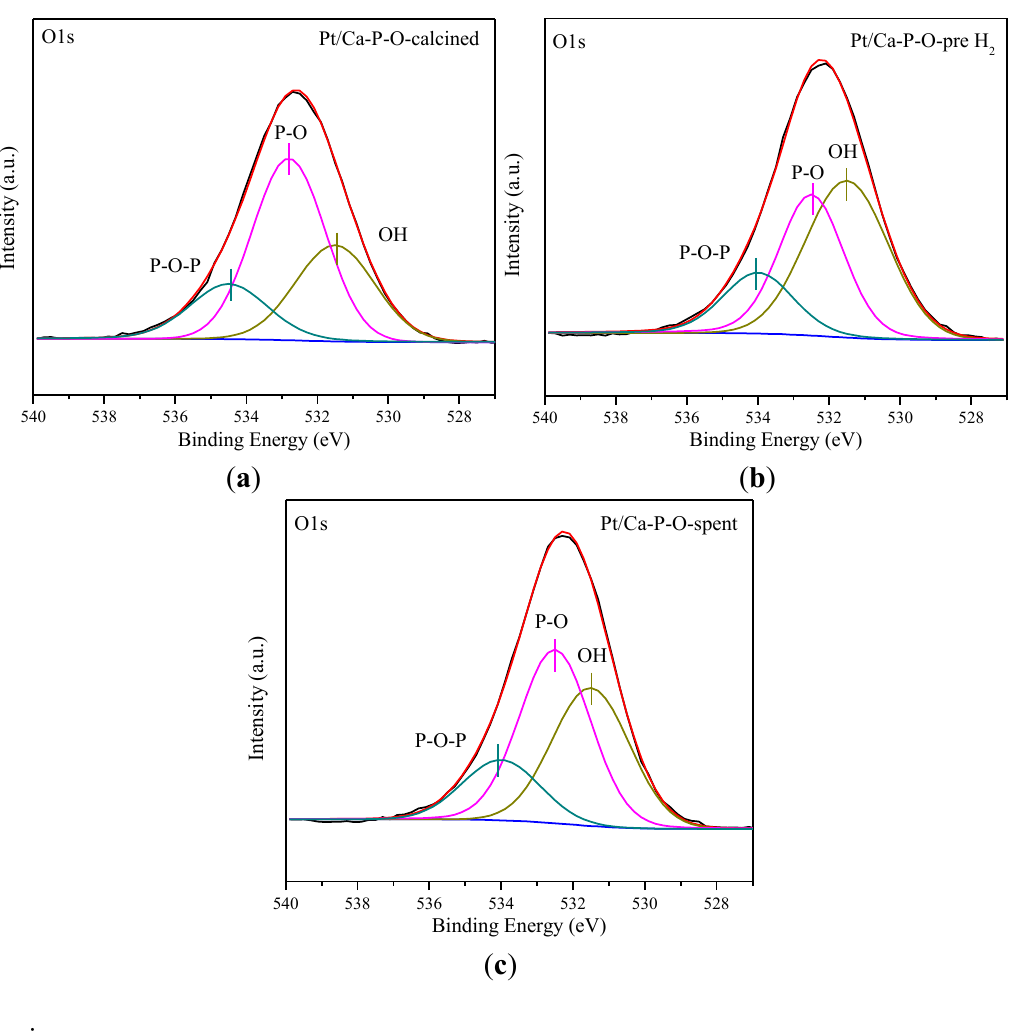
Figure 10. O1s XPS data of Pt/Ca-P-O-calcined ( a ), Pt/Ca-P-O-pre H 2 ( b ), and Pt/Ca-P-O-spent ( c